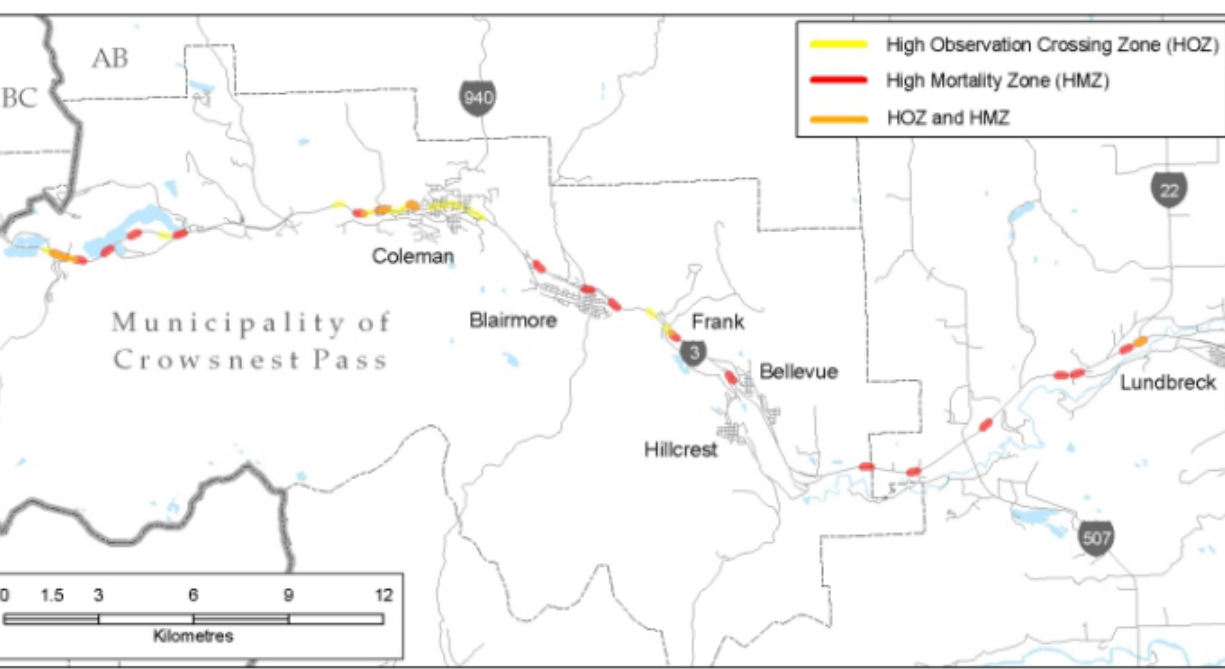
Fig. 5. Comparison of Road Watch wildlife high-crossing and high-mortality zones along Highway